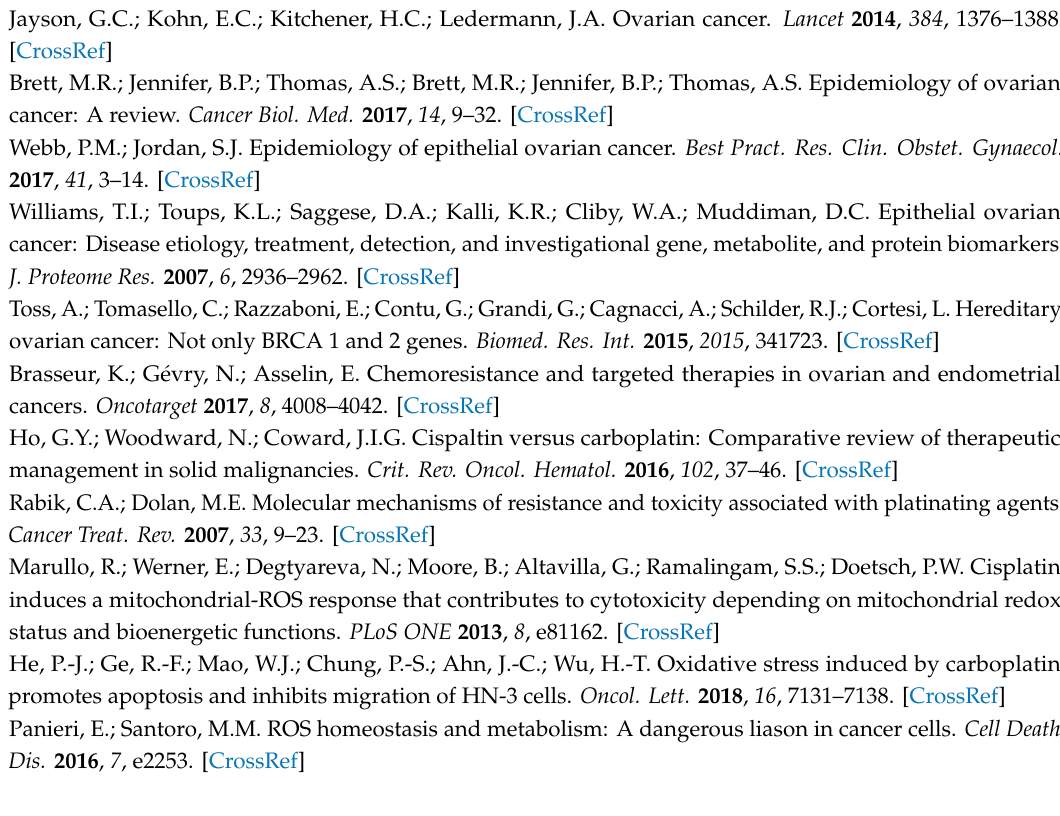
Figure S1: Determination of SeChry EC 50 for ES2 and OVCAR3 cell Lines. The e ff ective concentration 50 ( EC 50 ) was determined based on the cell death levels induced by di ff erent concentration of selenium-chrysin (SeChry) in ovarian cell lines. Cell death was determined by flow cytometry, measuring annexin V-FITC and propidium iodide (PI)